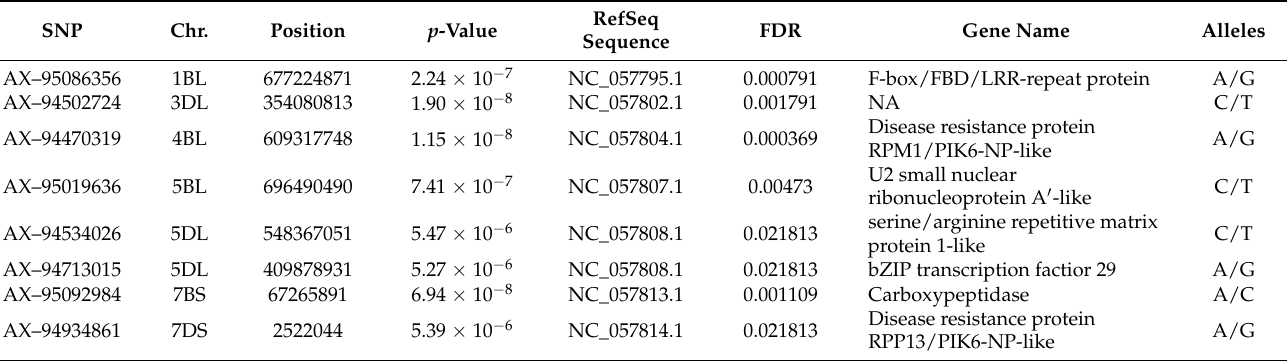
Figure 3. Manhattan ( a ) and quantile – quantile plots ( b ) of genome-wide associations study (GWAS) results of AX levels from 562 wheat genotypes. Eight SNPs associated with AX contents at − log( p ) > 5 thresholds through GWAS analysis are indicated by arrows. Table 1. Candidate genes and their functions for each significant single nucleotide polymorphism (SNP) associated with arabinoxylan levels.